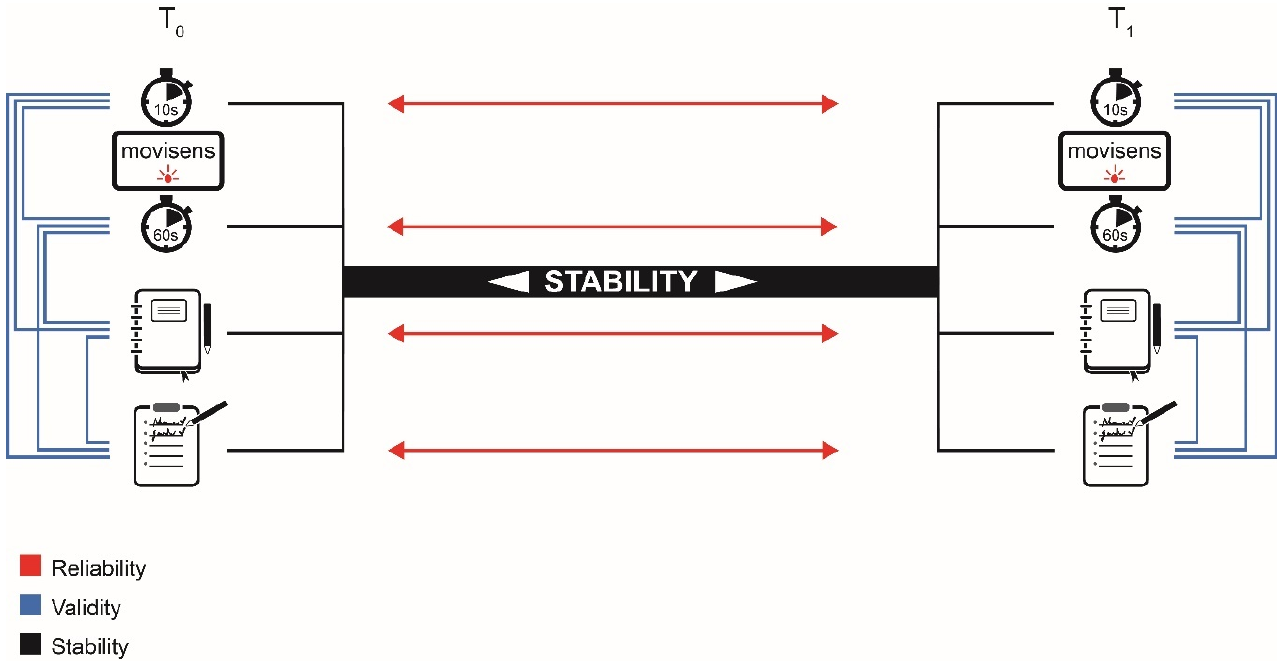
Figure 1. Study design. Displayed are the calculated combinations for validity (blue brackets) and reliability measures (red arrows) for the secondary aims concerning the parameters (from top to bottom) accelerometry using 10-s epochs and 60-s epochs, a physical activity diary, and the International Physical Activity Questionnaire. The main aim consisted in comparing the difference in total minutes for each bracket from T 0 to T 1 (black).